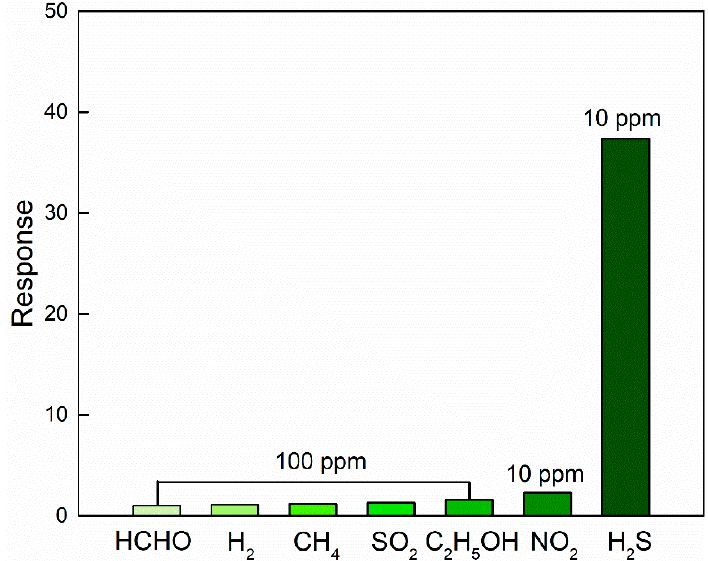
Figure 11. Responses of 1% Zn-doped α -Fe 2 O 3 nanowires upon exposure to different gases at the operating temperature of 175 °C.